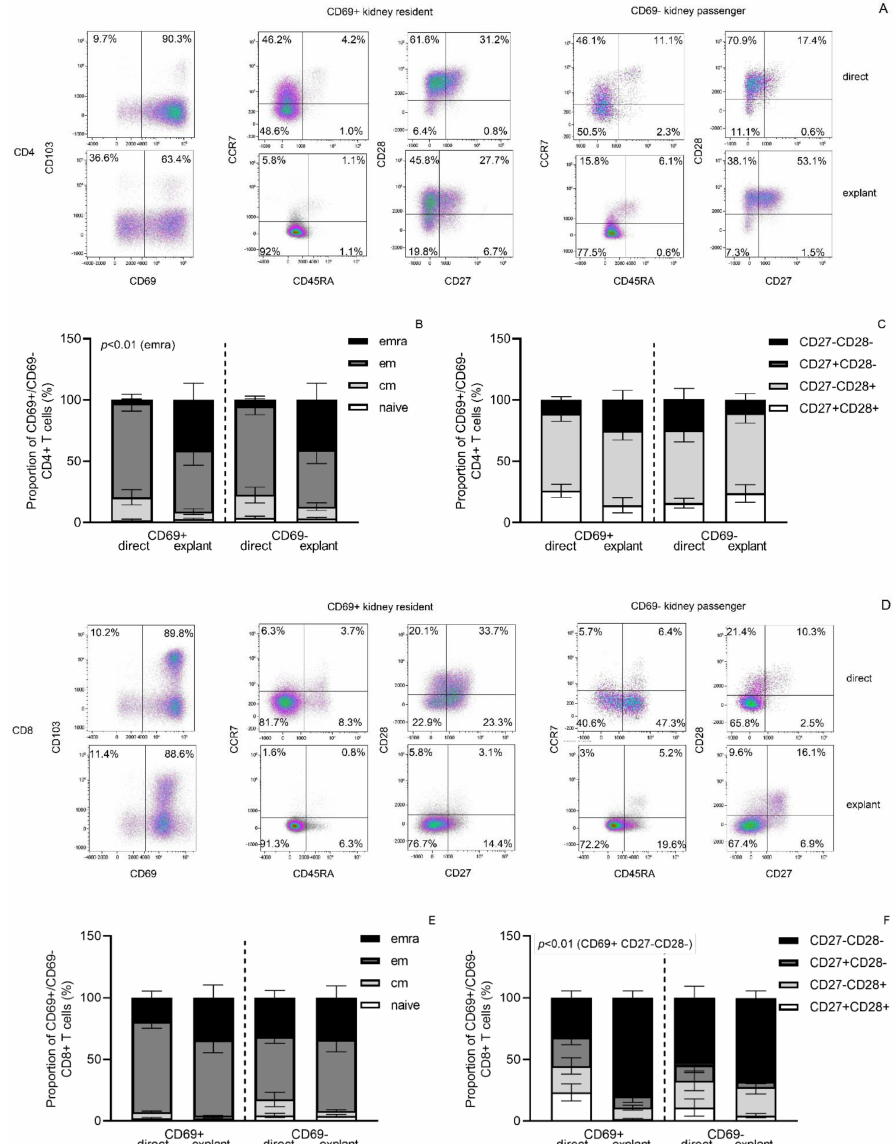
Figure 3. Explant culture in the presence of exogenous IL-2 and IL-15 resulted in more differentiated memory T cell subsets compared to T cells obtained following direct enzymatic processing of kidney tissue. In ( A , D ) a typical example of the flow cytometric gating strategy for phenotype of CD4+ ( A ) and CD8+ ( D ) T cells is depicted for those obtained following direct enzymatic processing of kidney tissue ( first row ) and those upon four weeks of explant culture in the presence of exogenous IL-2 and IL-15 ( second row ). T cells were characterized by flow cytometry following staining for T cell subsets using either antibodies directed to CCR7 and CD45RA ( B , E ) or CD28 and CD27 ( C , F ). Average ( ± SEM) proportions of T cells obtained from n = 11 kidney tissues ( n = 5 nephrectomies and n = 6 transplantectomies) are depicted in stacked bars. CM = central memory, EM = effector memory, EMRA = CD45RA+ terminally differentiated effect or memory T cells. Naïve T cells are identified as CCR7+CD45RA+, CM T cells as CCR7+CD45RA − , EM as CCR7 − CD45RA − and EMRA as CCR7 −